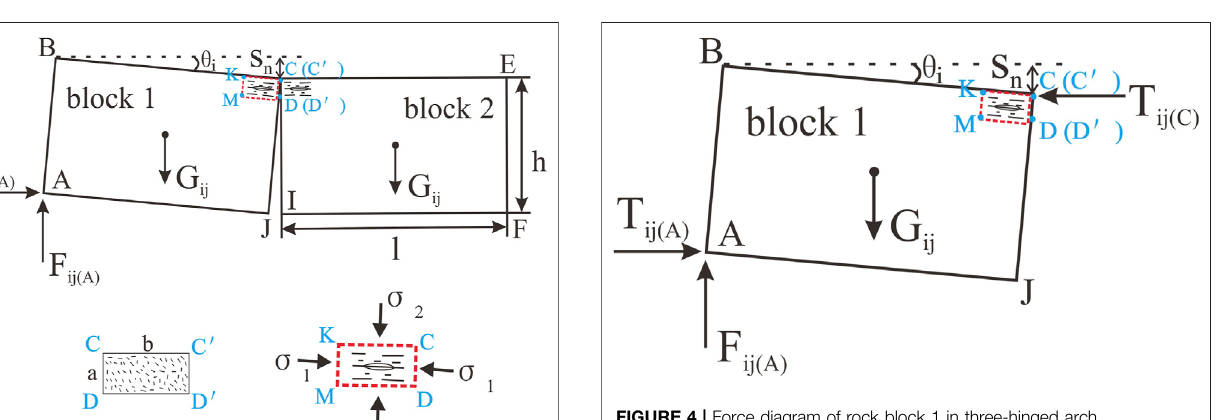
FIGURE 4 | Force diagram of rock block 1 in three-hinged arch